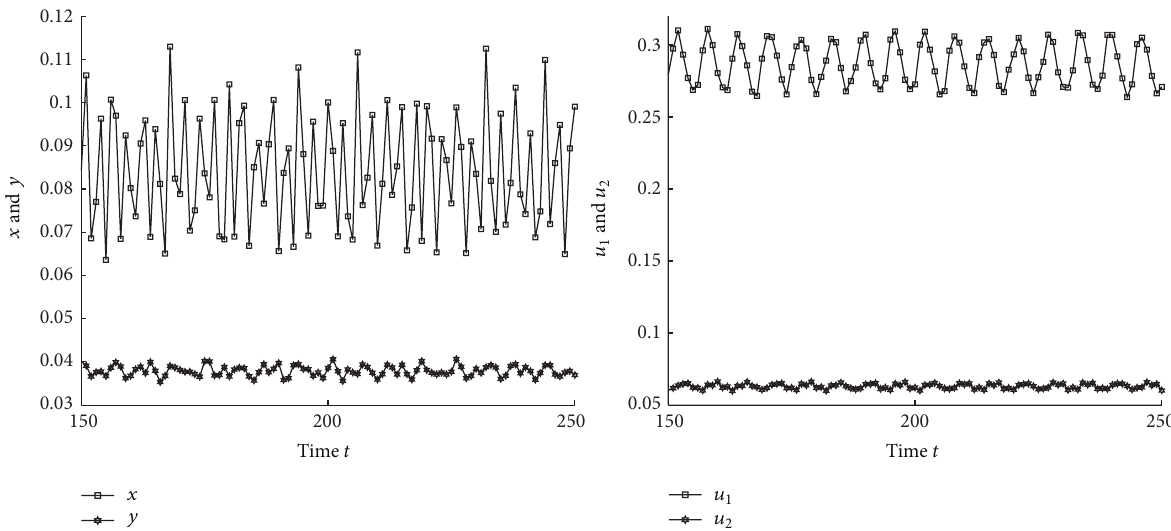
Figure 1: Dynamic behavior of the system (47) with the initial condition (𝑥(0),𝑦(0),𝑢 1 (0),𝑢 2 (0)) = (0.2,0.4, 0.1, 0.14) 𝑇 and (0.4, 0.5, 0.21, 0.3) 𝑇 ,